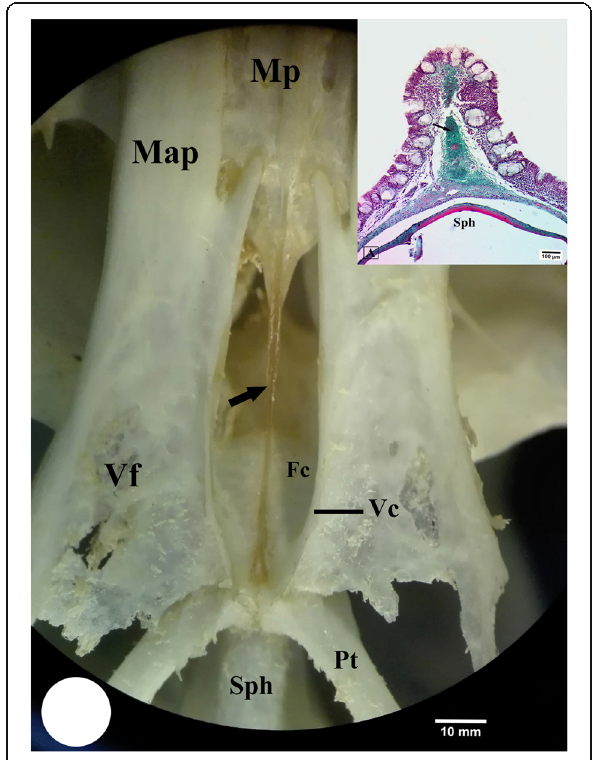
Meanwhile, in hoopoe and the common moorhen, the movable naso-frontal hinge gives flexibility for depression of the upper jaw by pulling the palatine bone during the contraction of the pterygoid muscle. During depression of upper jaw in the common moorhen, the force transferred to curve the anterior portion of the palatine bone “ maxil- lary process of the palatine bone ” . This force enables bird to widen the choana. Morphologically, widening of choana